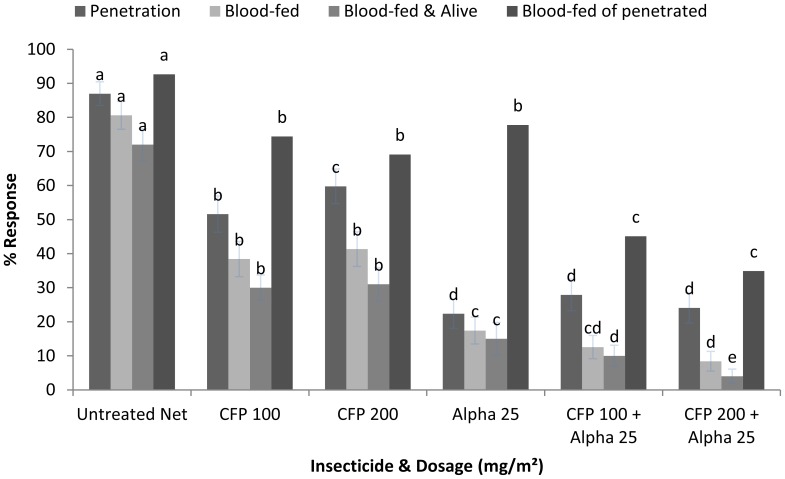
Percentage response of pyrethroid susceptible Cx. quinquefasciatus in tunnel tests.Percentage response for parameters related to repellency and blood-feeding for ITNs treated with CFP alone (100–200), alpha alone (25), and mixtures of CFP (100/200)+Alpha (25). If the superscript in a time period (0 h, 24 h, 48 h, 72 h) is the same there was no significant difference between treatments (P>0.05) (n = 350 p/treatment).